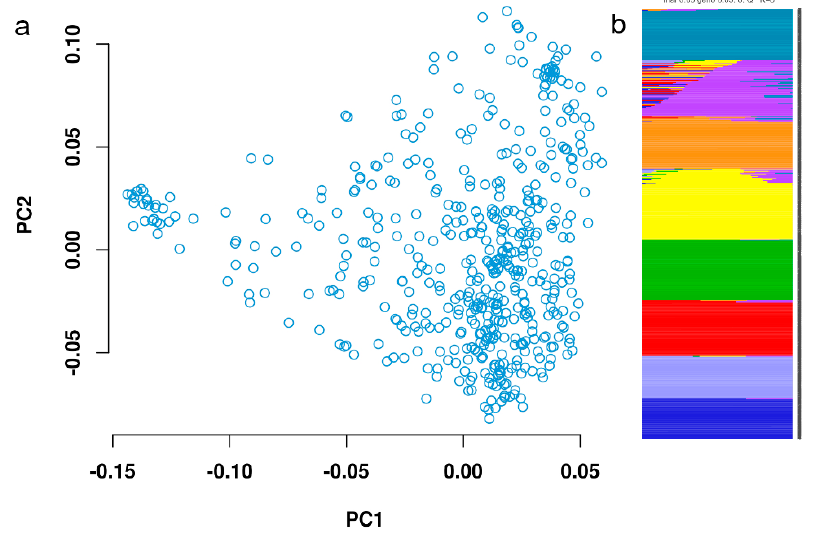
Figure 2. Principal component analysis 3D diagram and population structure diagram. (a) Principal component analysis. Each point in the PCA diagram represents a sample, and the information used in the drawing is the position of these samples on the two axes of PC1 and PC2. (b) The optimal population structure. Different colors represent different subgroups.